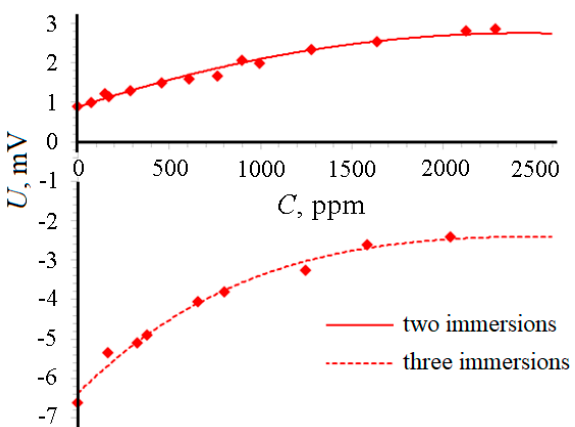
Figure 3. Concentration dependence of the electromotive force for the ZnO/ZnO–Fe samples ( T = 200 ° С ).